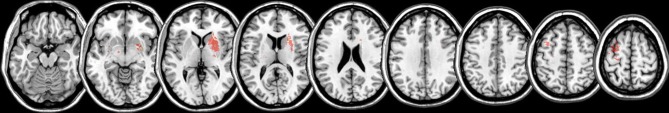
Lesion map. Lesion mapping (color coded in red) overlay on the MNI reference brain for all 14 patients investigated. Predominantly right subcortical and left hemispheric cortical lesions are seen.